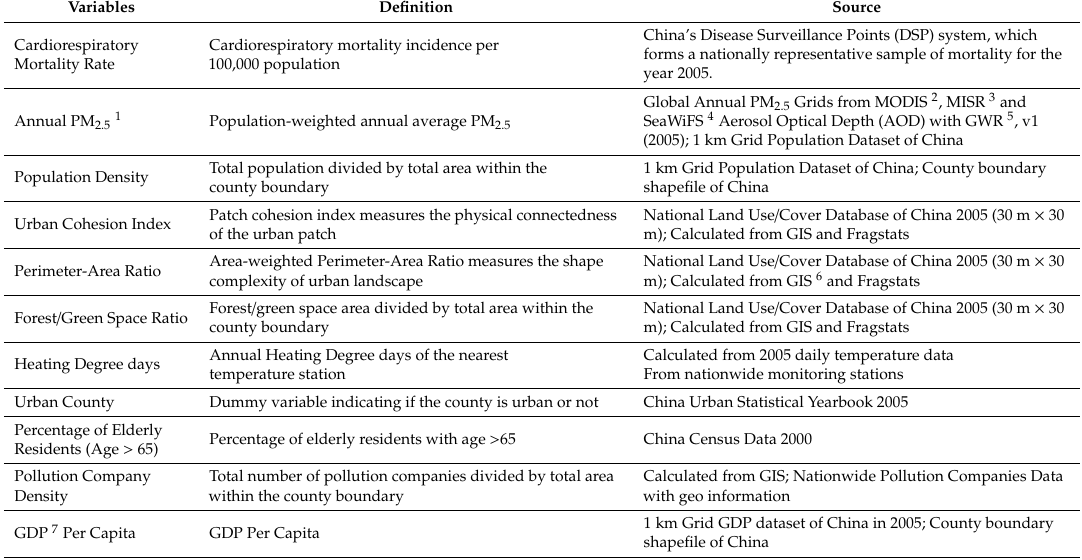
Table 1. Definitions and sources of variables used in this study.